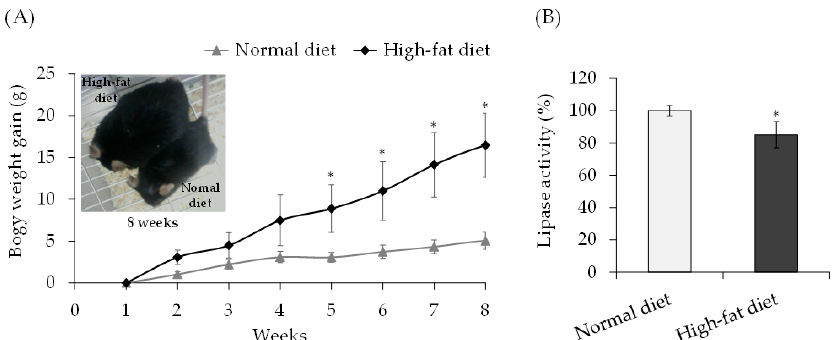
Figure 4. Lipase activity in mice fed a high-fat diet. ( A ) Body weight changes in mice fed normal and high-fat diets. ( B ) Comparison of lipase activity in mice fed normal and high-fat diets. The values represent the mean ± standard deviation (SD) of five independent experiments on five mice. * The significance level was p < 0.05 compared with normal diet.